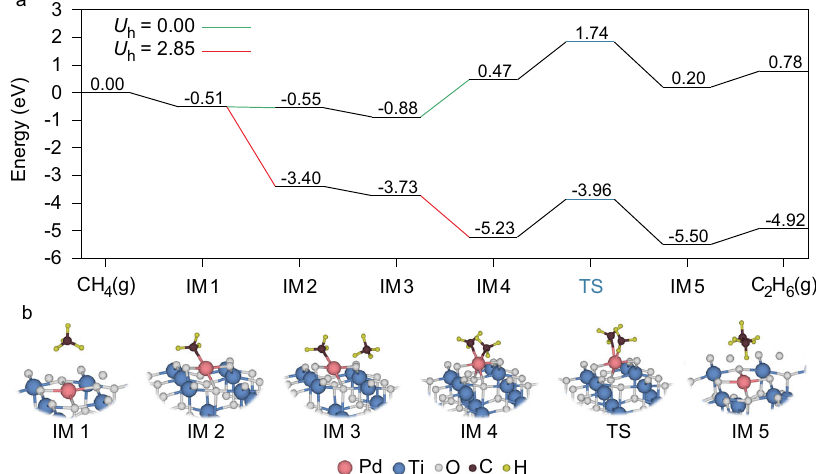
Fig. 4 DFT calculations for photocatalytic NOCM. a Free-energy diagrams for C 2 H 6 production on Pd 1 /TiO 2 with hole energy ( U h ) of 0 eV and 2.85 eV. b Atomic con fi gurations for the corresponding steps in the